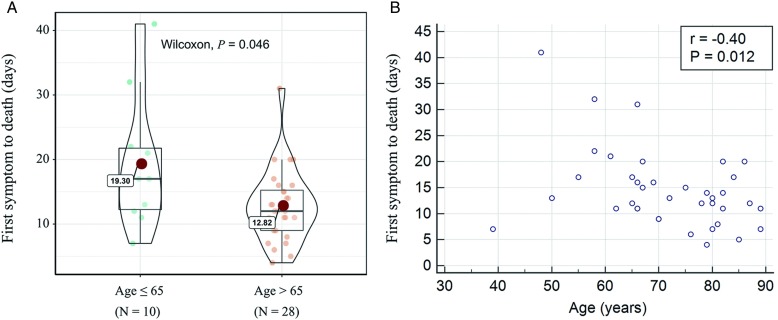
A,B, Influence of Age on the Time of First Symptom to Death (Days). A, Violin plots for age. B, Correlation between age and the time of first symptom to death (days).